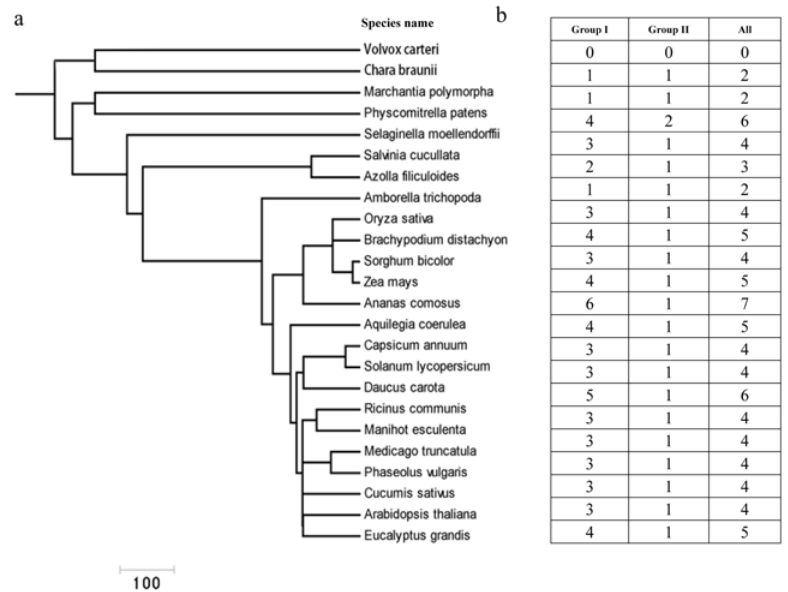
Figure 1. Retrieval and identification of Cu/Zn SOD genes in different plant species ranging from green algae to higher plants. ( a ) Phylogeny of different plant species from green algae to higher plant species. ( b ) The distribution of Cu/Zn SOD genes in representative